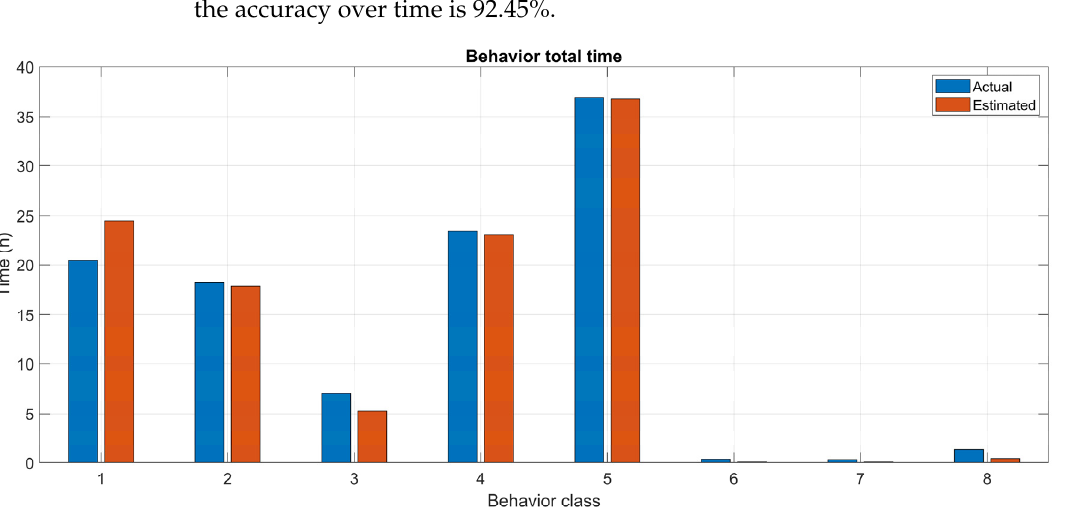
Figure 12. Time accuracy of the combined classifier of actual and estimated behavioral classes. Numbers on the x -axis refer to the behavior classes: 1 = standing; 2 = lying; 3 = standing and ruminating; 4 = lying and ruminating; 5 = eating; 6 = drinking; 7 = walking; 8 = other. Table 5. Relative error of the combined classifier for the relevant classes of actual and estimated behavior.